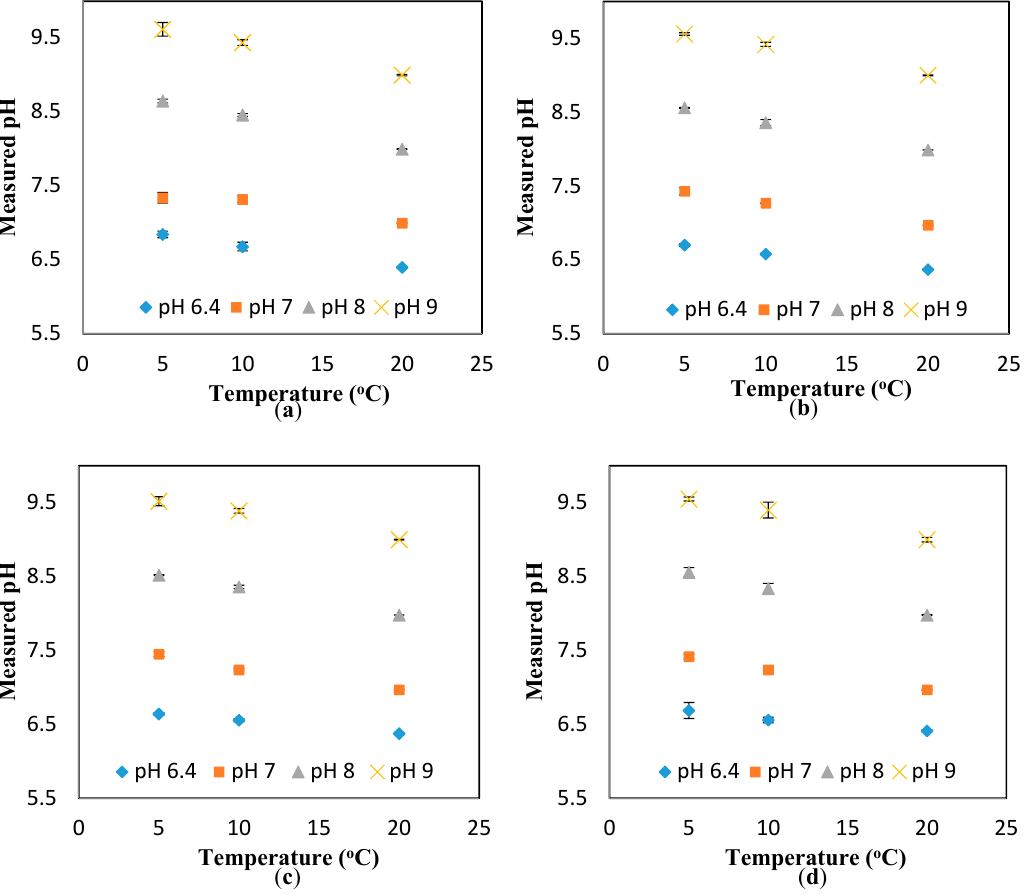
Figure A5. Effect of temperature on the response of the sensors for different pH solution at the flowrates of ( a ) 0 mL/min; ( b ) 10 mL/min; ( c ) 20 mL/min; and ( d ) 30 mL/min.